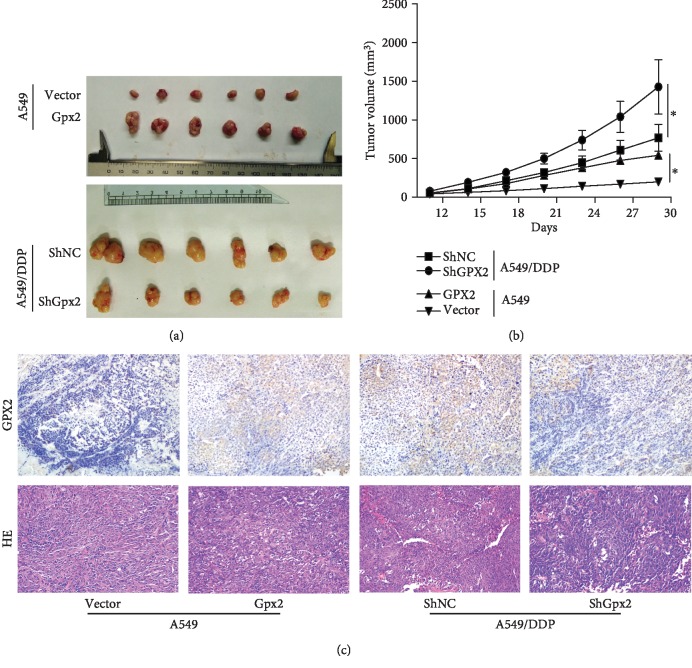

In vivo effects of GPX2 expression in DDP resistance. Cells (2 × 106 cells/100 μL PBS) were subcutaneously inoculated into the right flank of BALB/c nu/nu mice, and the animals were randomly separated into 4 groups (6 per group) according to which cells they were inoculated with. The mice were intraperitoneally injected with a suspension of PBS containing DDP (2.5 mg/kg) twice per week, after the tumor volume grew to ≈100 mm3. (a) The mice were sacrificed, and the tumors were isolated after 4 weeks. (b) The tumor size was monitored every 3 days after cells implantation. (c) Hematoxylin-eosin (HE) staining was performed, and GPX2 protein was detected by immunohistochemistry (magnification ×200). ∗p < 0.05.